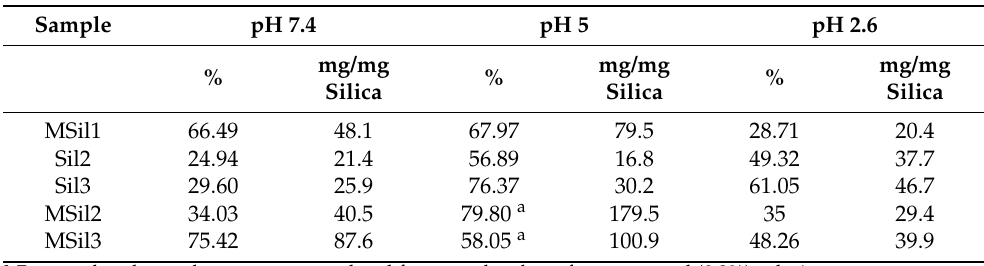
Table 5. Maximum release capacity (% from encapsulated Dox) in different conditions, after 72 h and amount of Dox released per mass of silica